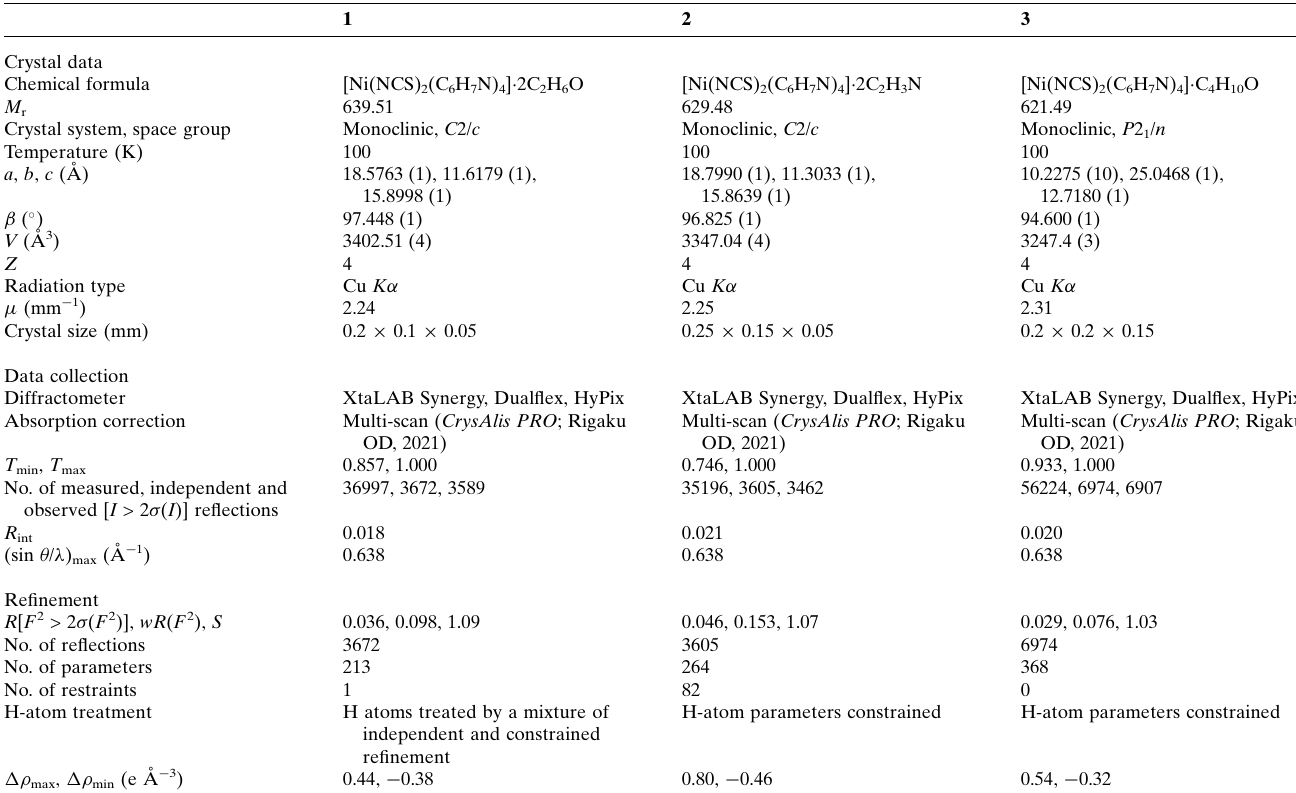
Table 5 Experimental details.